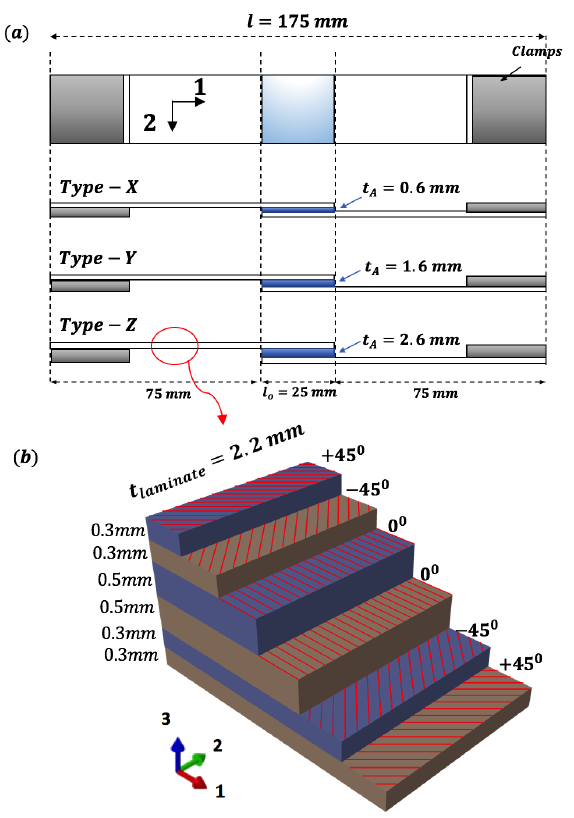
Figure 7. ( a ) Configuration of prepared adhesive joints and ( b ) layup of top and bottom